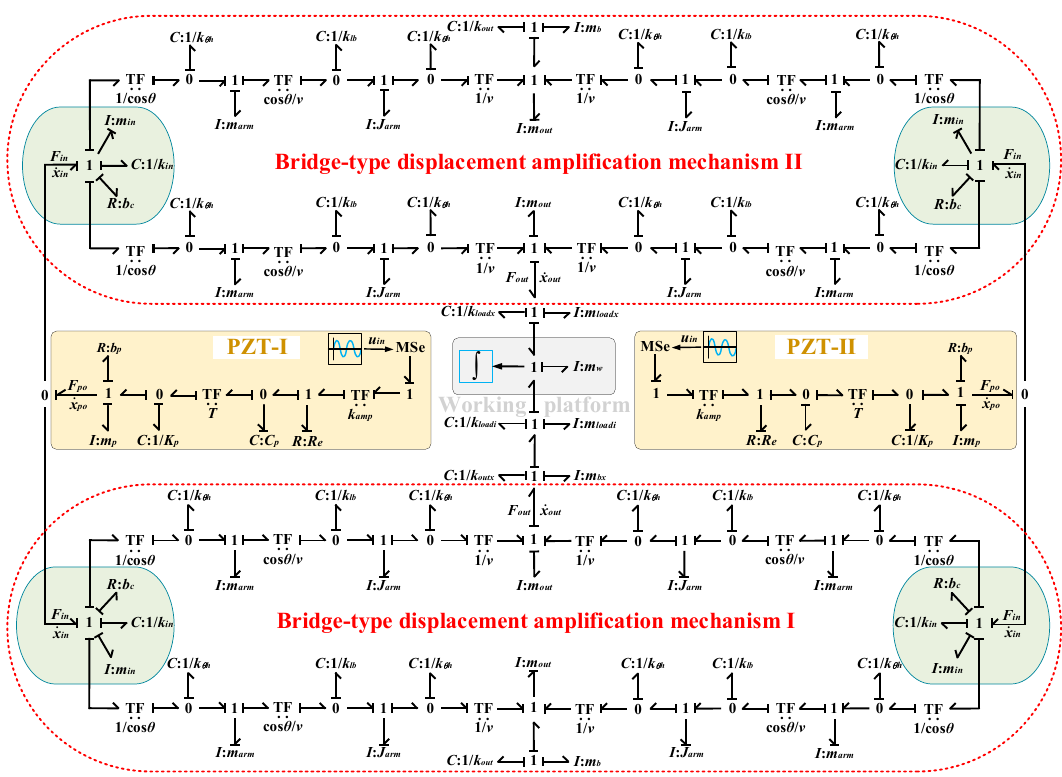
Figure 10. Bond graph model of the compliant platform system.